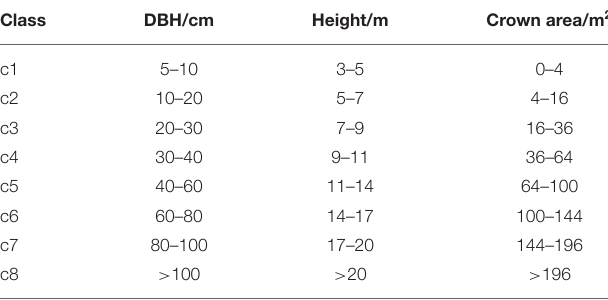
TABLE 2 | Specific class classifications for DBH, height, and crown area in this